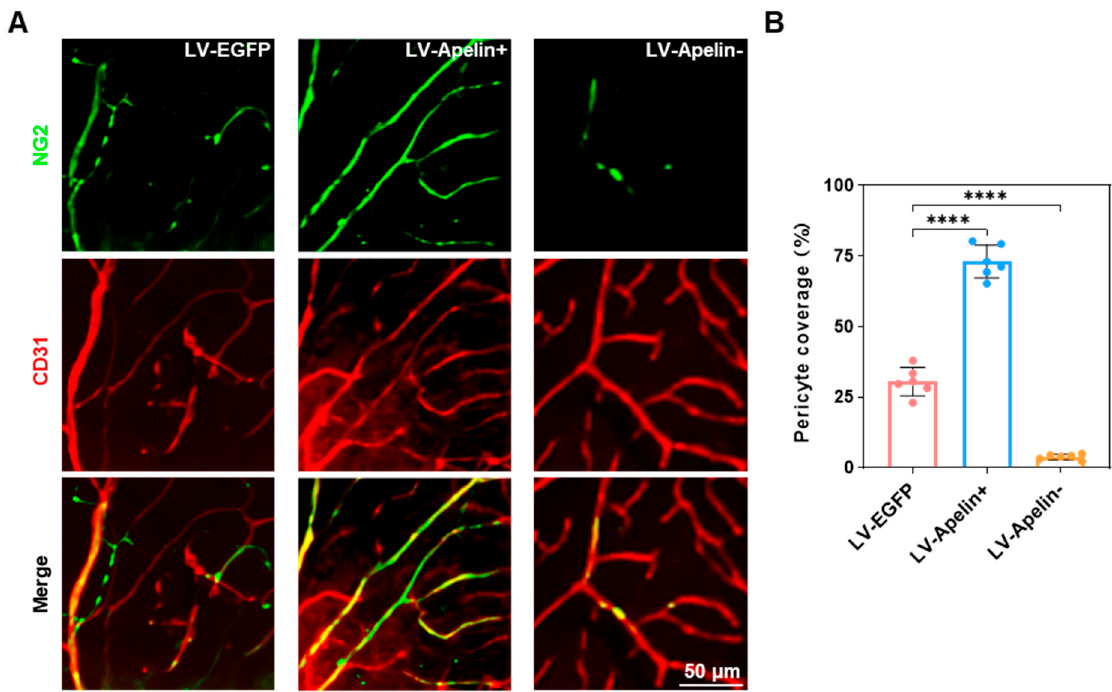
Figure 3. The expression of pericytes in DR mice treated with LV-EGFP, LV-Apelin+, or LV-Apelin − . ( A ) Representative NG2 and CD31 staining images by CLSM and ( B ) the quantification of pericyte coverage indicated that there was a partial loss of pericytes in the LV-EGFP group, while the expression of pericytes increased in the LV-Apelin+ group but decreased in the LV-Apelin − group. Green: NG2, Red: CD31. Data were expressed as mean ± SD. LV-Apelin+ versus LV-EGFP; LV-Apelin − versus LV-EGFP; **** p < 0.0001 (n = 6).